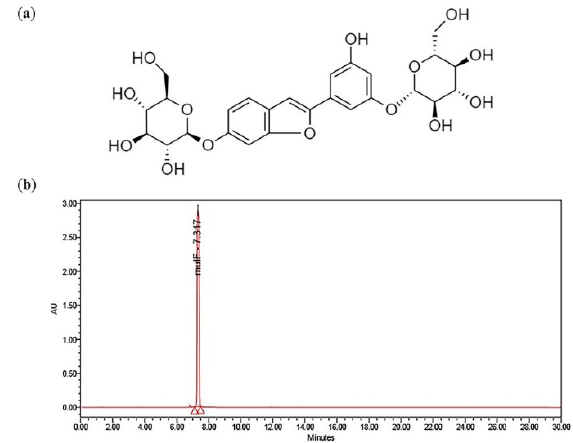
Figure 1. Mulberroside F (moracin M-6, 3 ′ -di-O-beta-D-glucopyranoside) from Morus species. ( a ) Chemical structure; ( b ) HPLC chromatogram of mulberroside F standard.